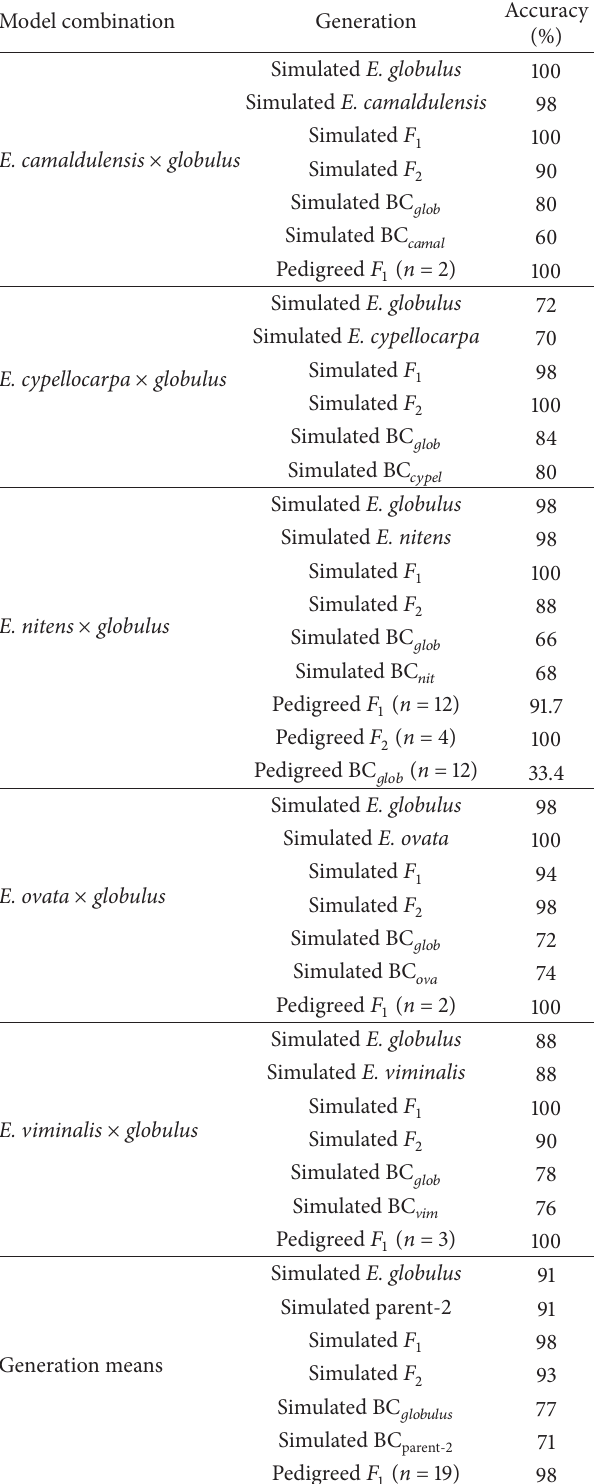
Table 3: The overall accuracy of assignment of simulated parental and hybrid individuals and pedigreed hybrids between Eucalyptus globulus and five other species, based on Bayesian cluster analysis using q > 0.2 to identify hybrid individuals (see Supplementary Material 1 for more detail). Each simulated generation consisted of 50